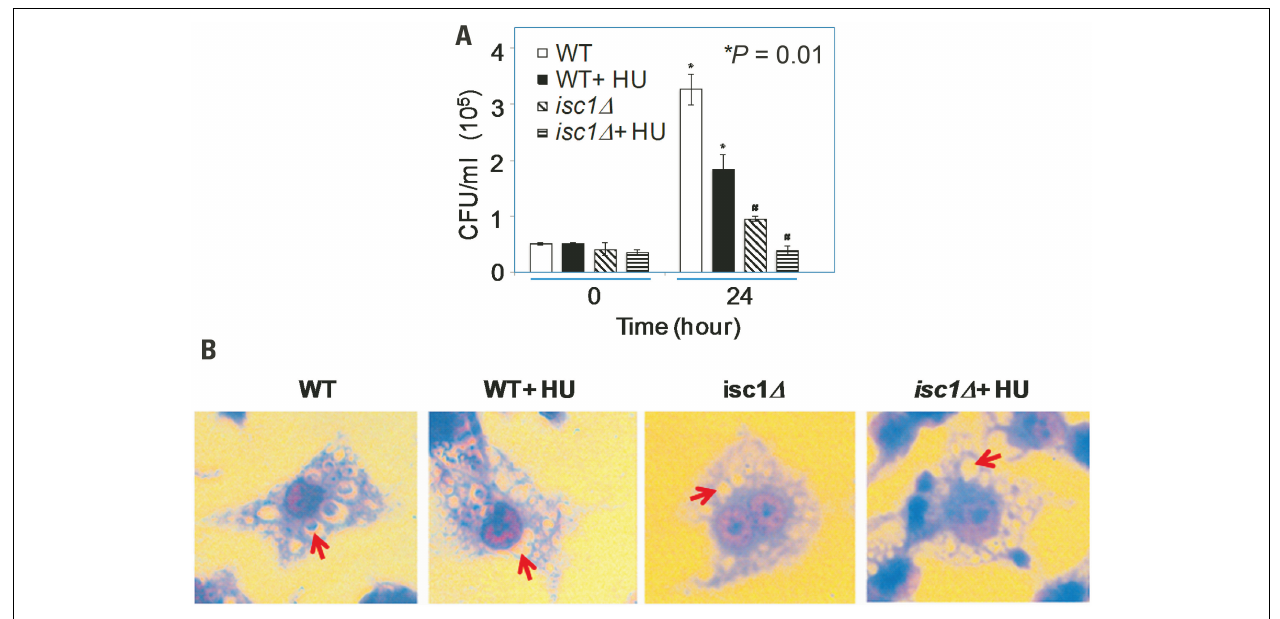
microscope equipped with a CCD camera. All images were captured under oil immersion ( × 100). Red arrows indicate the presence/absence of Cryptococcus in the phagolysosomes of macrophages. Most phagolysosomes in untreatedWT cells contained Cn cells, whereas some HU-treatedWT cells still contained Cn cells. In contrast, most macrophages did not contain Cn isc1 (cid:2) cells regardless of HU